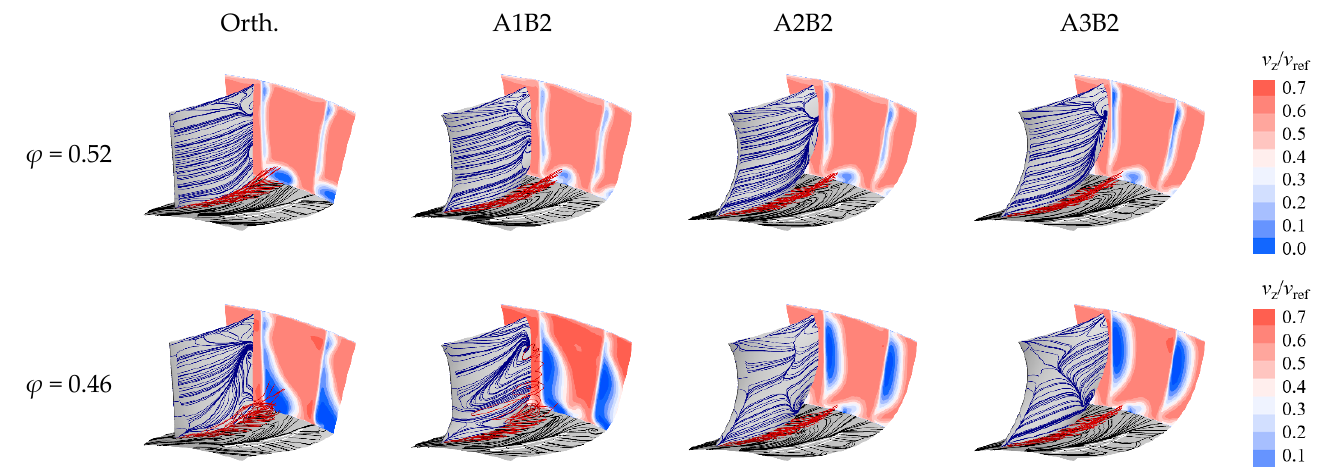
Figure 6. Flow field distribution for the cases with different sweep heights.